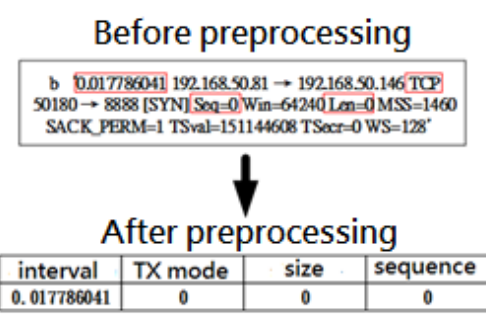
Figure 10. The result of data preprocessing for packet feature capture. Table 3. The packet features dataset.